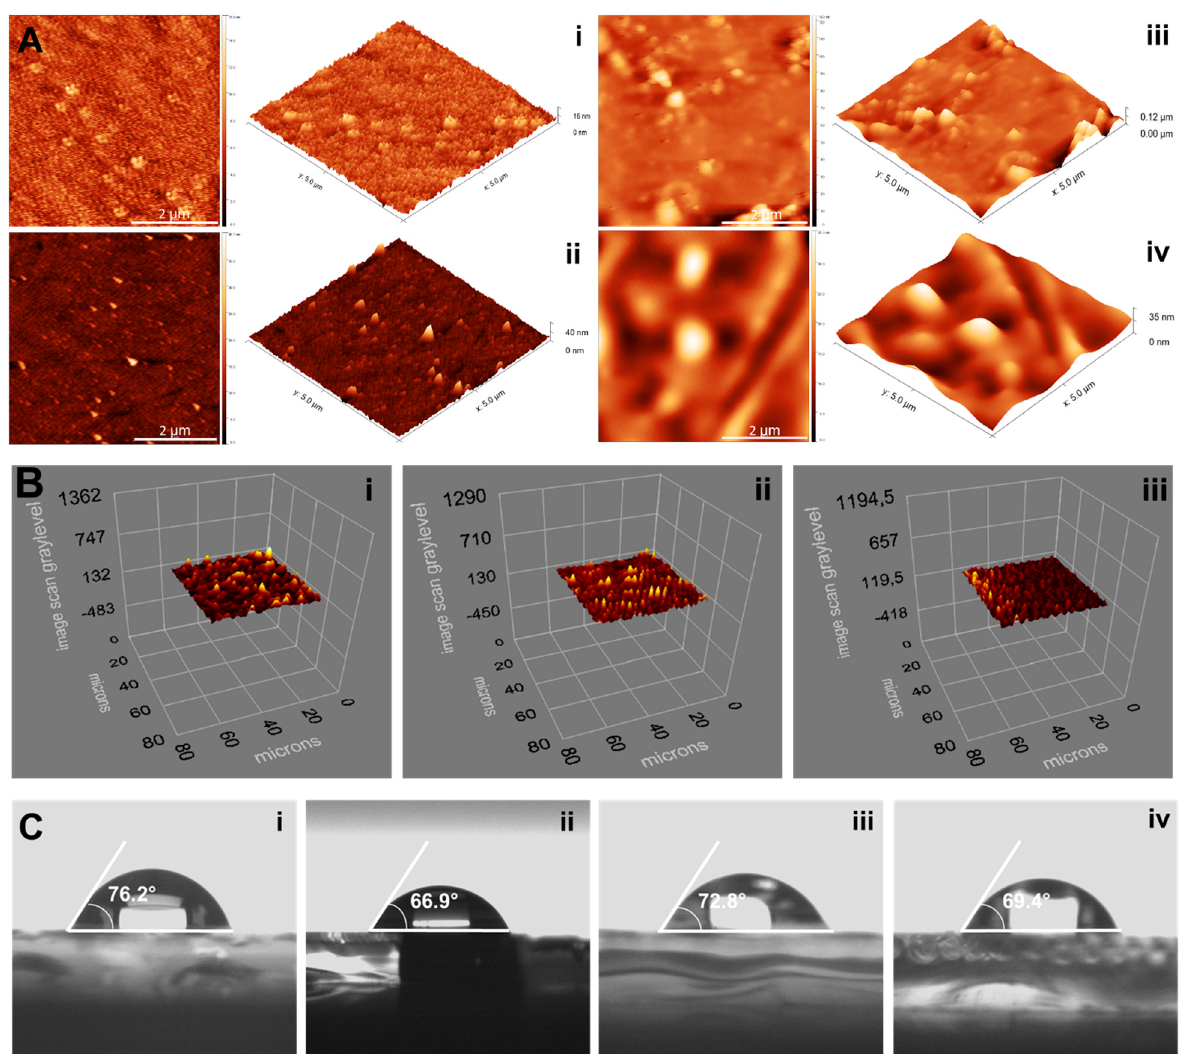
Figure 2. AFM ( A : bare ( i ), allylated ( ii ), Cu(II)-imprinted ( iii ) and non-imprinted ( iv )) ellipsometry ( B : allylated ( i ), Cu(II)-imprinted ( ii ) and non-imprinted ( iii )) and contact angle ( C : bare ( i ), allylated ( ii ), Cu(II)-imprinted ( iii ) and non-imprinted ( iv )) images of plasmonic sensors. The thickness values of allylated, Cu(II)-imprinted and non-imprinted plasmonic sensor surfaces were determined as 75.1 ± 2.7 nm, 87.6 ± 2.6 nm, and 82.5 ± 2.9 nm